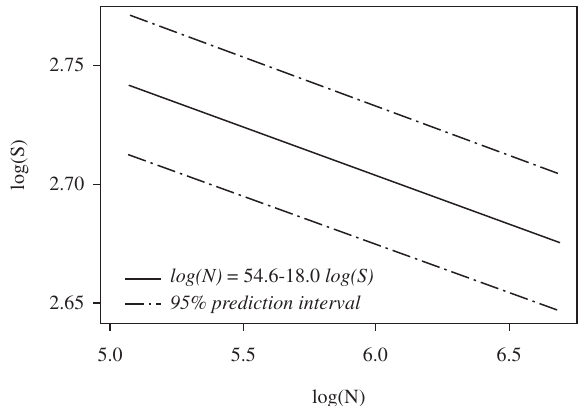
Figure 9. S-N curve and 95% prediction intervals for the surface rolled notch